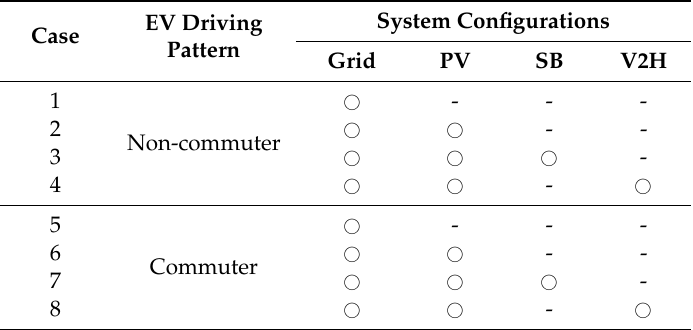
Table 1. Combinations to be